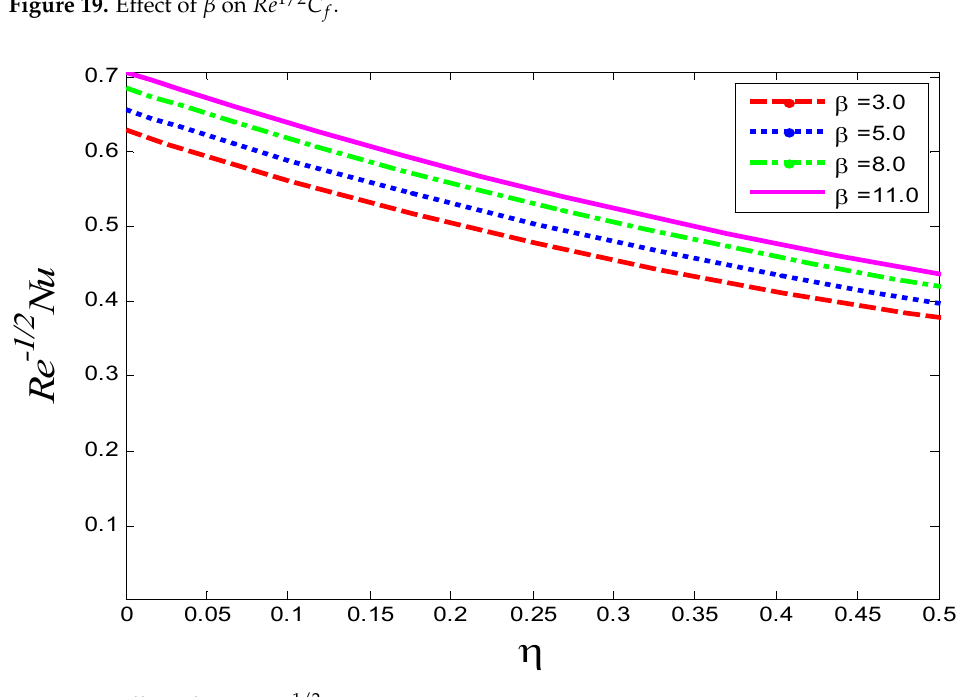
Figure 20. Effect of β on Re − 1/2 Nu .